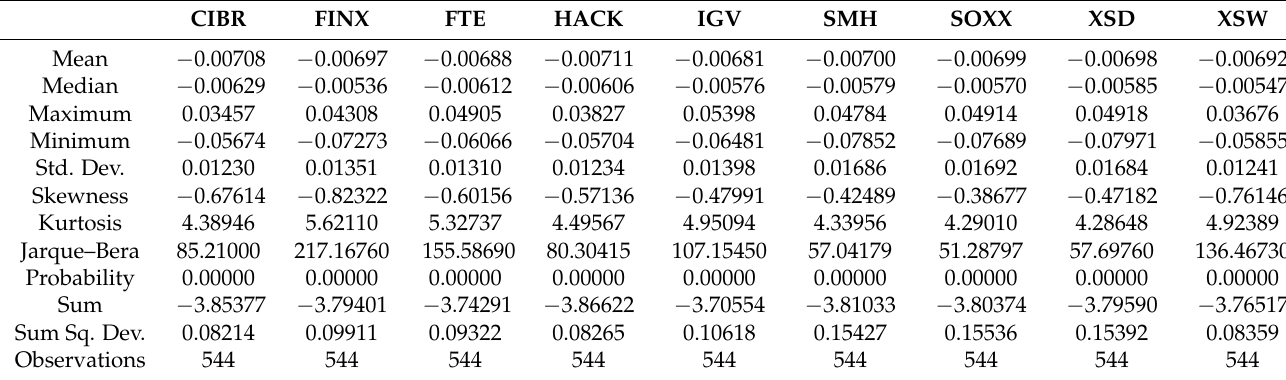
Table 1. Summary statistics for daily excess returns of the nine exchange traded funds (ETFs).